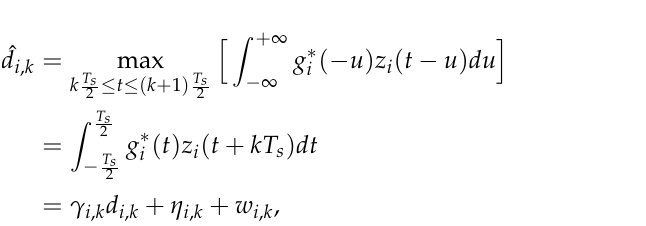
Figure 1. Scheme of Time-Division Multiple Access